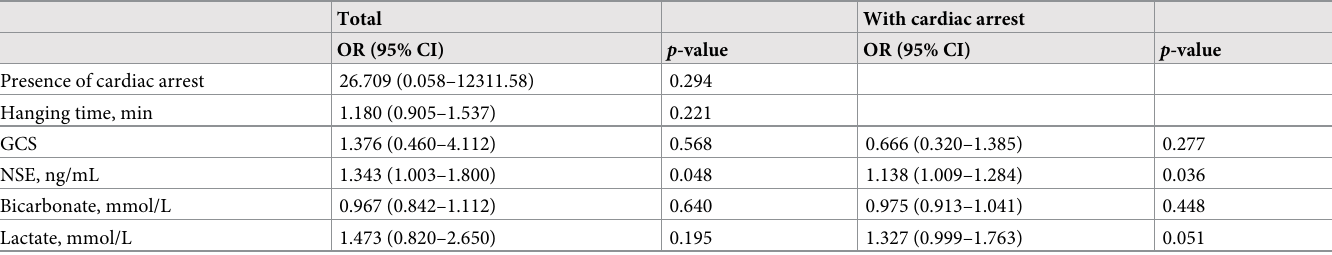
Table 4. Multivariable logistic regression analysis to identify variables predicting a poor neurological outcome.